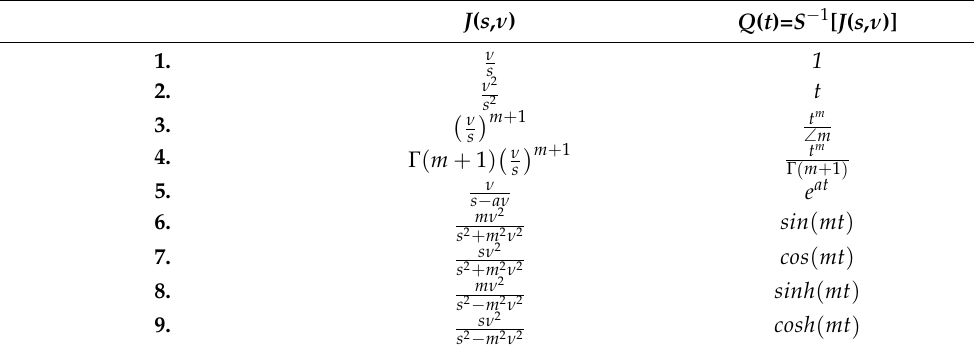
Table 3. Chart regarding the inverse Shehu transform